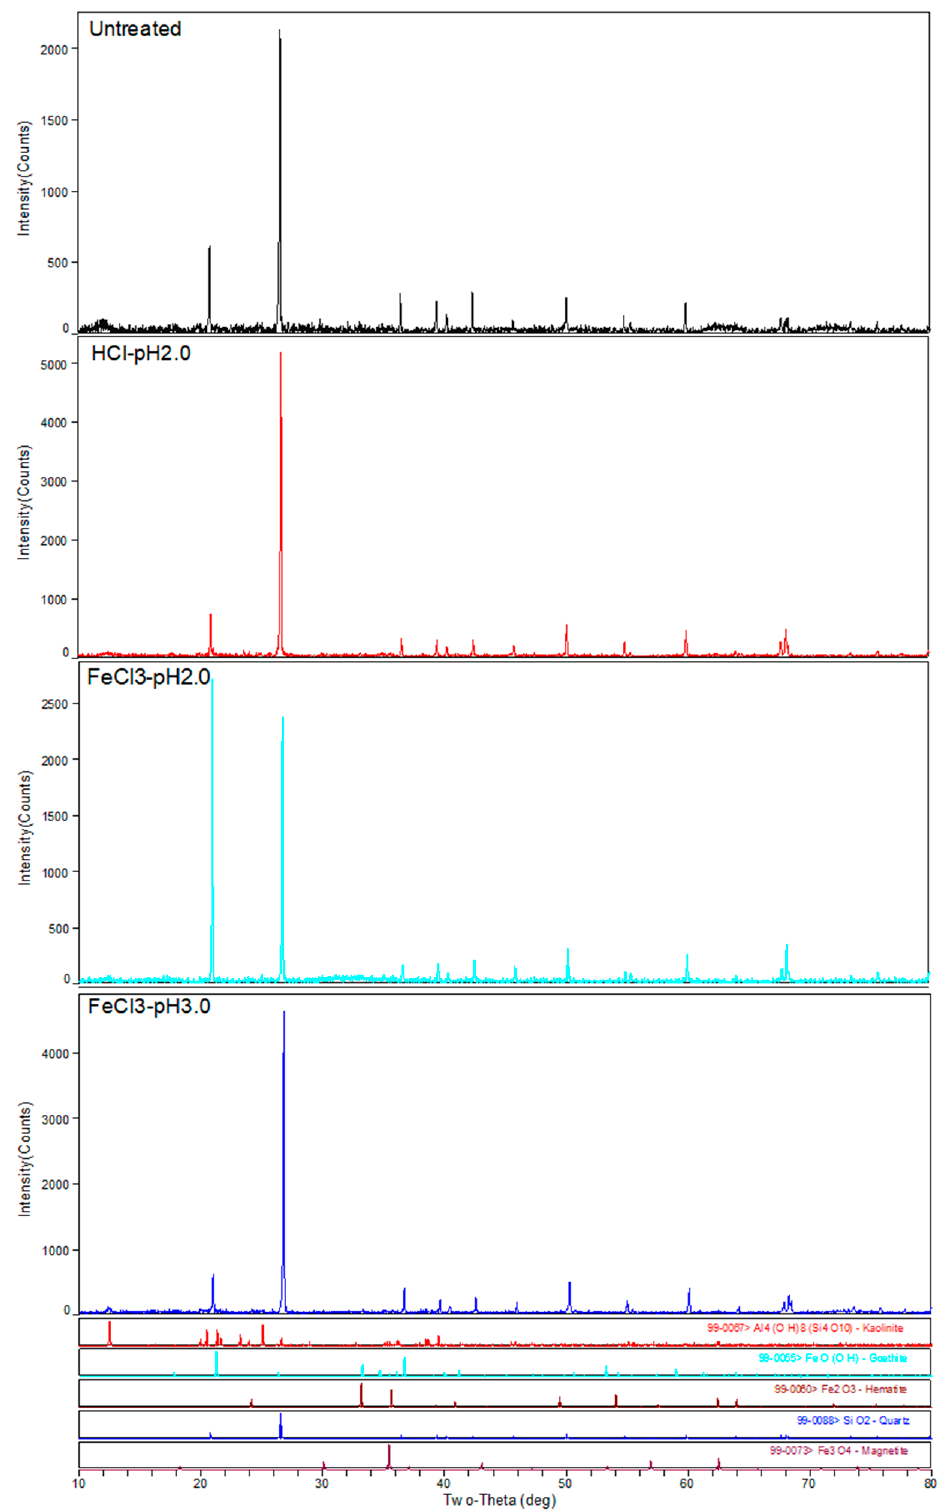
Figure 3. X-ray diffraction patterns for differently treated soils.